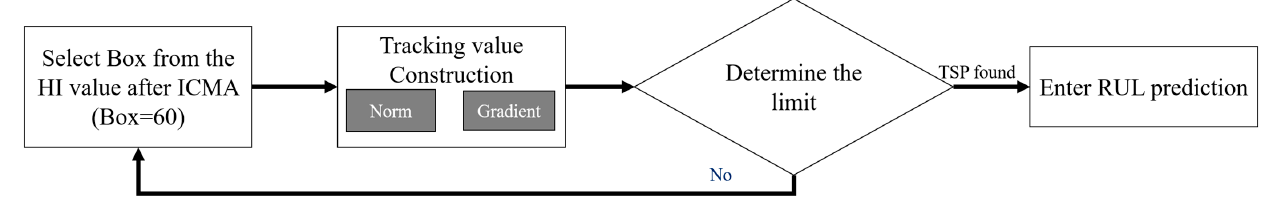
Figure 6. TSP detection